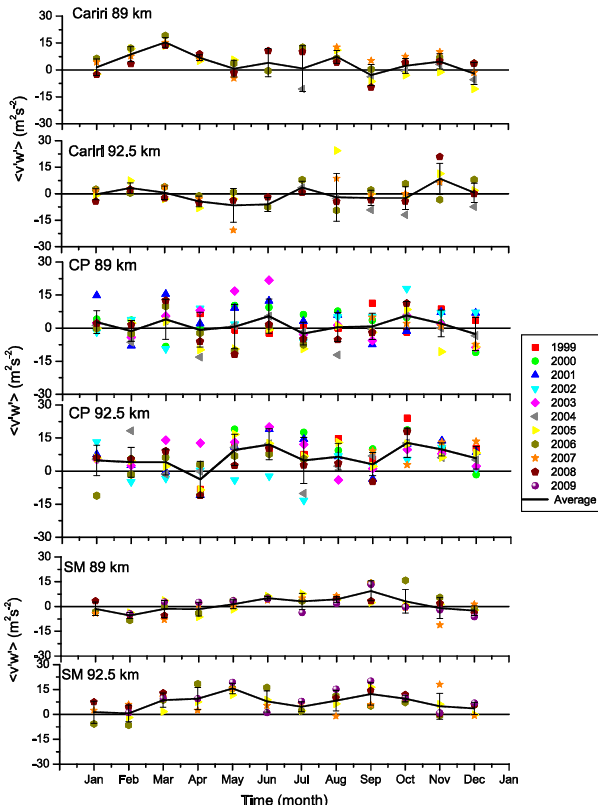
Figure 5. The same as Fig. 4 but for monthly mean meridional mo- mentum